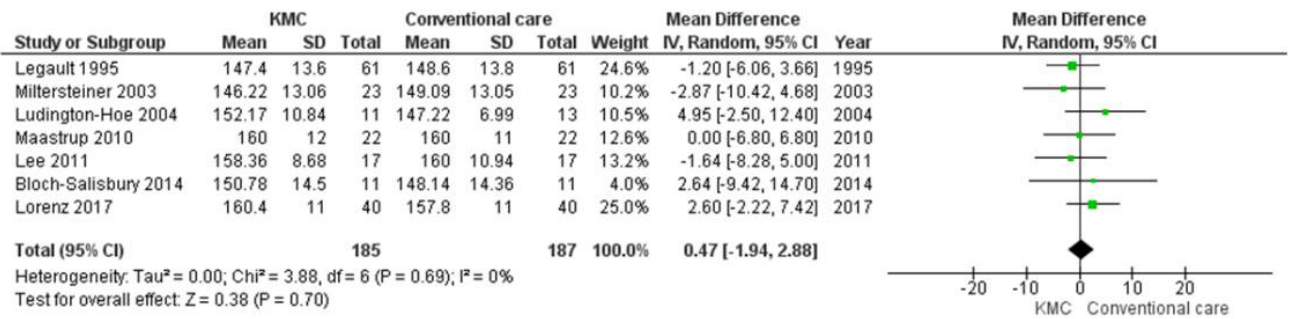
Figure 4. Forest plots for effects of KMC compared with conventional care on heart rate and respiratory rate (beats/min).